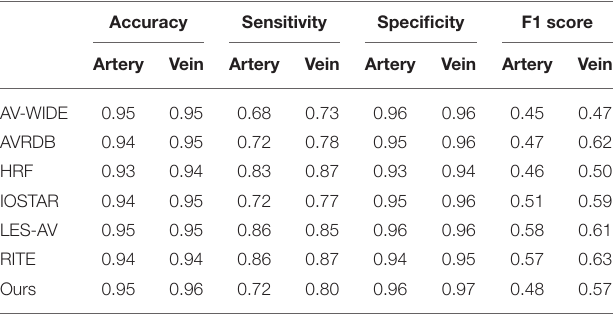
and severe DR. Blue pixels represent false negatives (pixels that were manually labeled but missed by the model). Red pixels represent false positives (pixels identified by the model but missed by manual labeling). Green pixels represent pixels